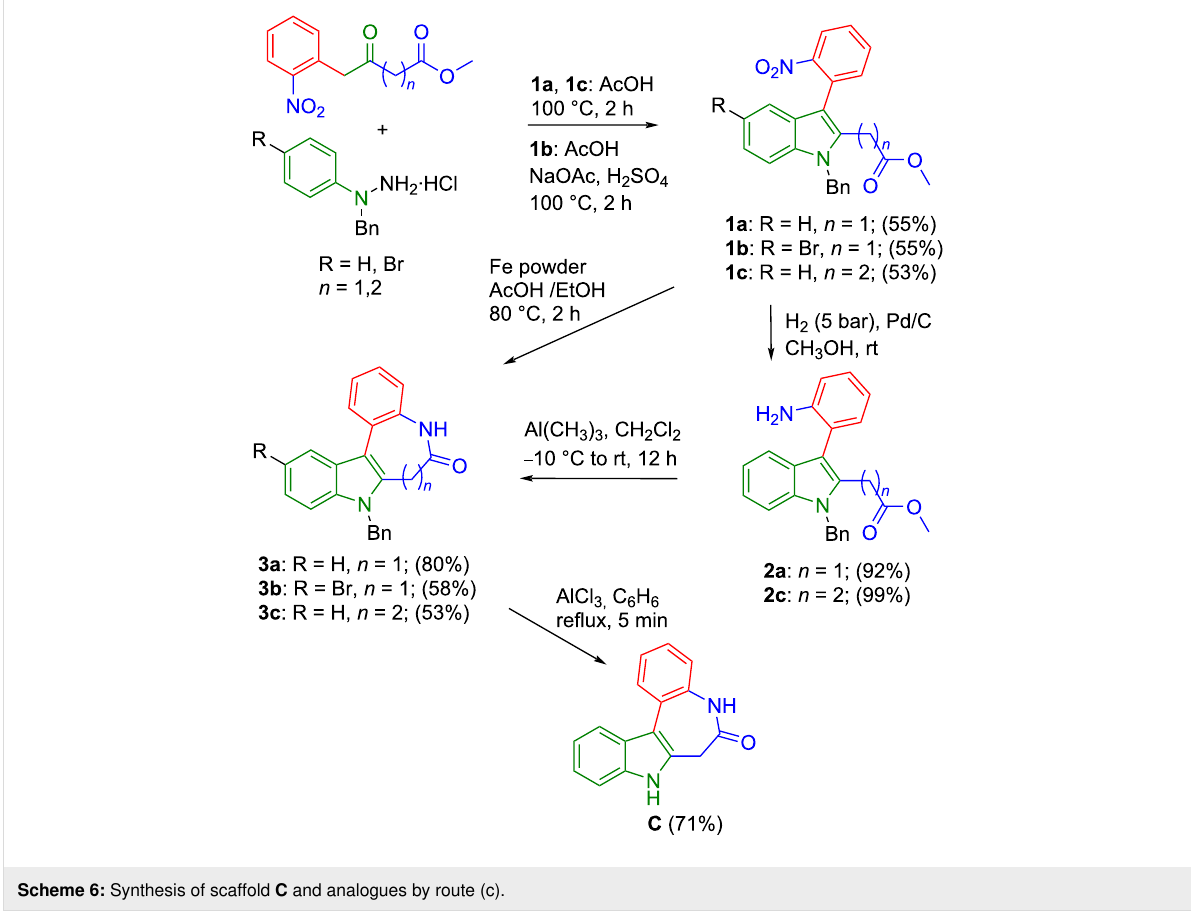
[43]. For comparison, debenzylation of paullone with sodium in liquid ammonia gave A in 40% yield [23].